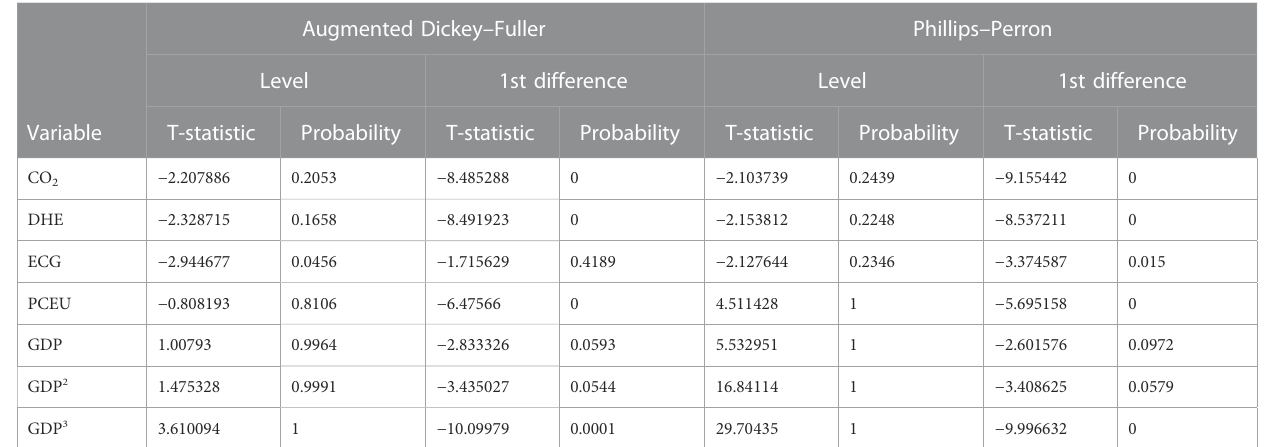
TABLE 2 Unit root testing results.